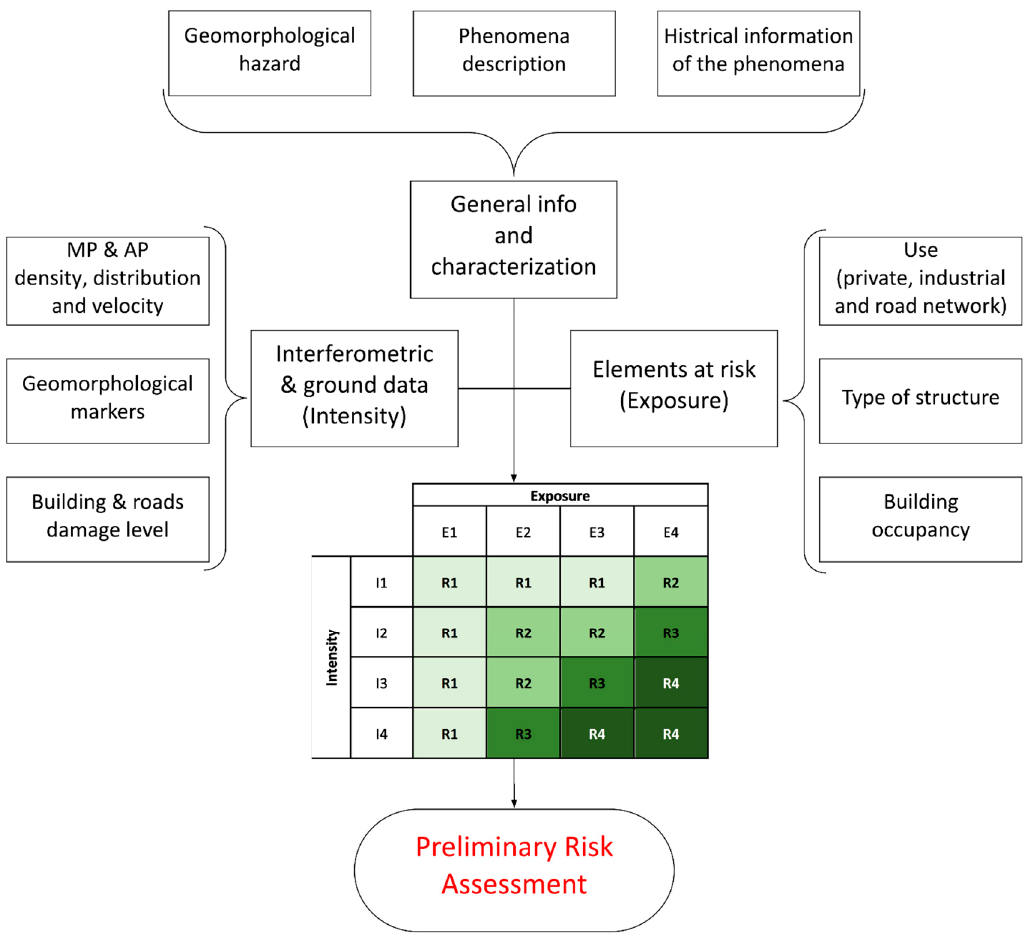
Figure 5. Flowchart of the field survey to collect all the data for combining the Intensity (I) and Exposure (E) for the preliminary risk (R) evaluation. Table 3. Suggestions and actions that should be taken for each class of Risk (R).